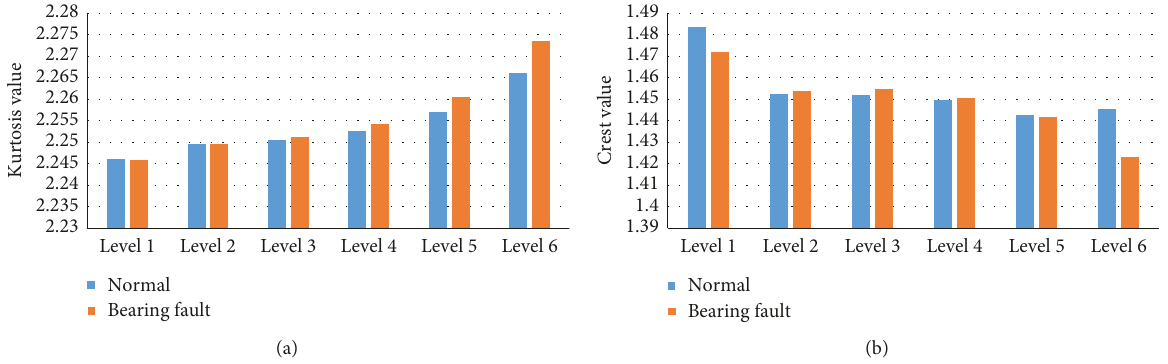
Figure 8: (a) Kurtosis factor and (b) crest factor of multiple-level WPD